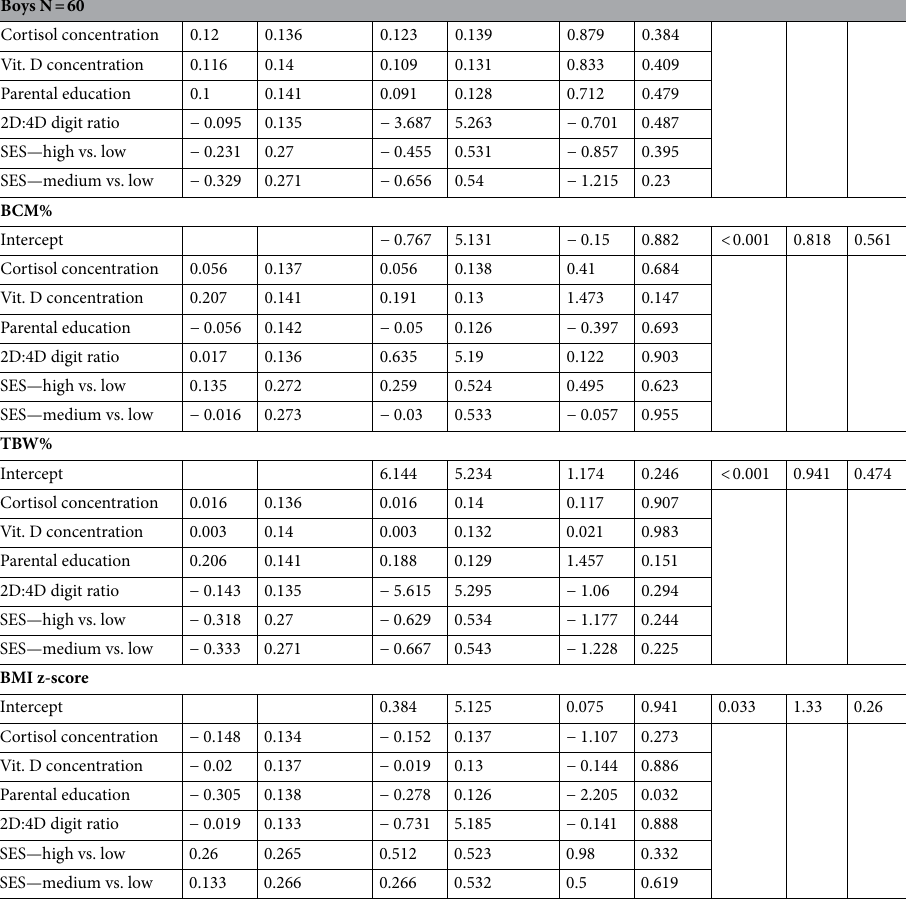
Table 3. Multiple regression models for all predictor variables (FM%, MM%, BCM%, TBW%, and BMI), separately for boys and girls, included the following outcoming variables: the vitamin D and cortisol concentration, 2D:4D digit ratio (right hand), the standard of living (three categories) and parental education. Bonferroni correction: threshold of significance p <